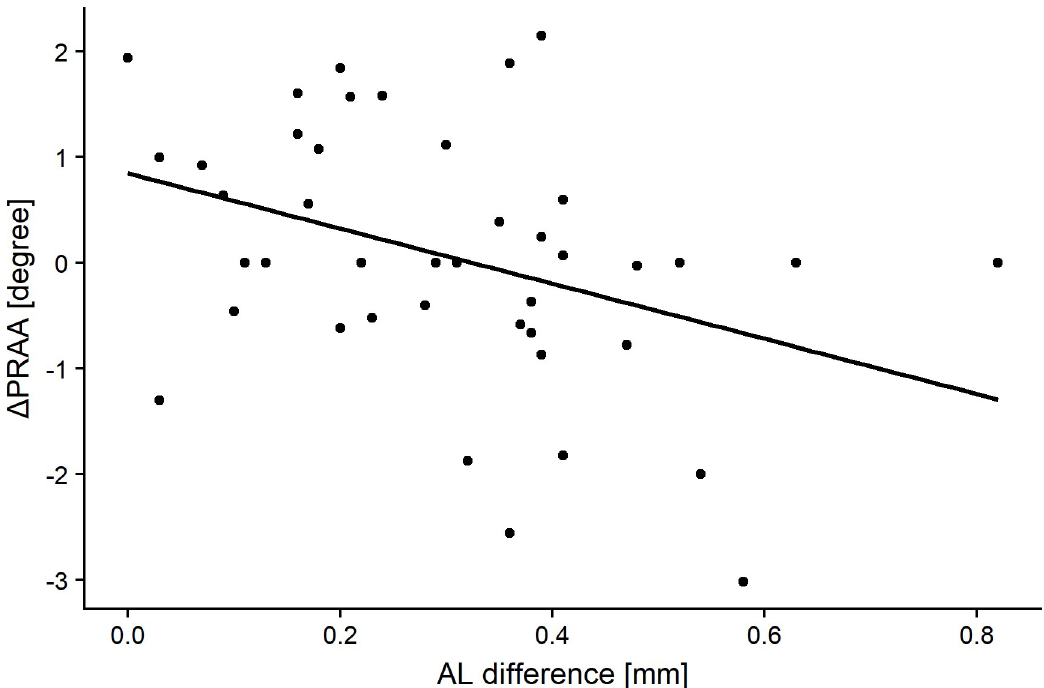
Fig 5. The relationship between change in the peripapillary retinal arteries angle ( Δ PRAA) and the difference in the axial length of the subjects when in the third and first grades ( Δ AL). Significant correlations were obtained (R = -0.37, p = 0.014, Pearson’s product-moment